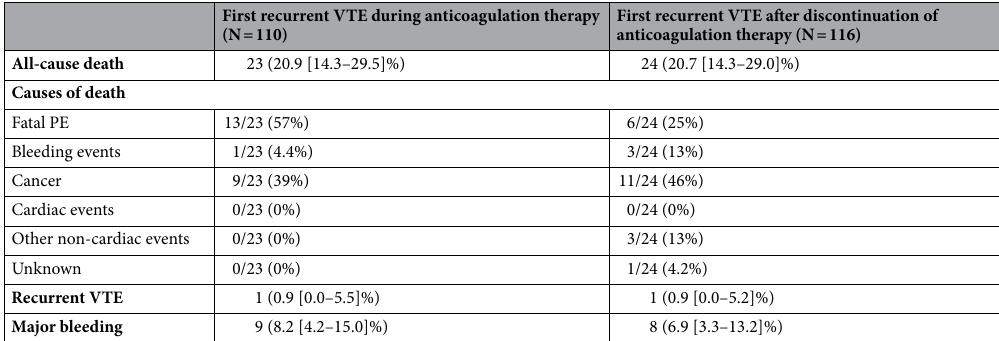
Table 4. Clinical outcomes at 90 days after first recurrent VTE events. The 90-day clinical outcomes after the first recurrent VTE are presented as the number of events and incidences with 95% confidence intervals. Death was judged to be due to PE (fatal PE), if it was confirmed by autopsy or if death followed a clinically severe PE after first recurrent PE events. Death was judged to be bleeding-related, if it followed an intracranial haemorrhage or a bleeding episode leading to hemodynamic deterioration. Death from end-stage cancer without a specific cause of death was regarded as of cancer origin. Death was judged to be due to cardiac events, if it followed acute myocardial infarction, heart failure, or ventricular arrhythmia. VTE venous thromboembolism, PE pulmonary